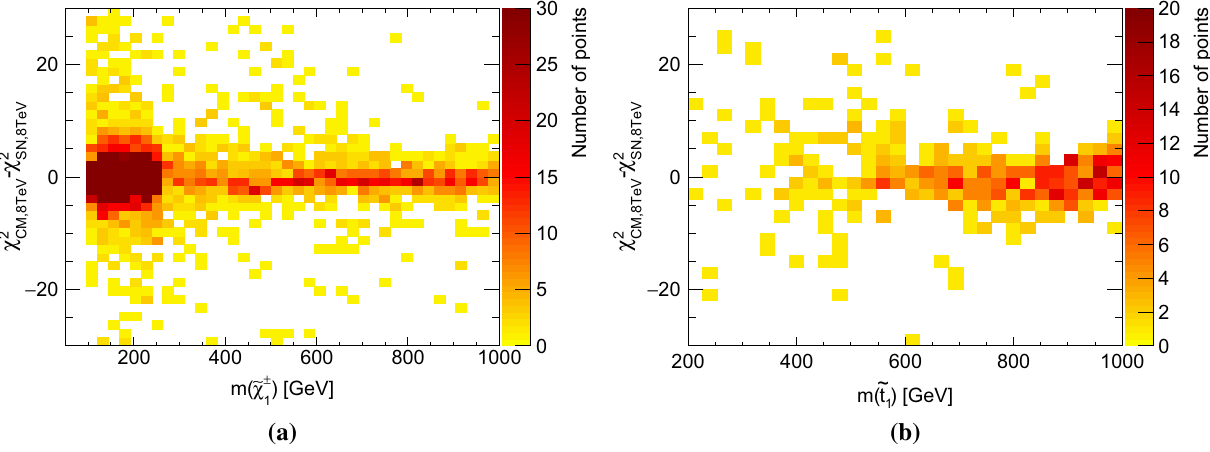
Fig. 11 All validation points with m ( ˜ g ) > 1 . 5 TeV and m ( ˜ q 1 , 2 ) > 1 . 5 TeV are used to produce the two plots. In a we show the differ- ence between the SCYNet parametrization and the CheckMATE